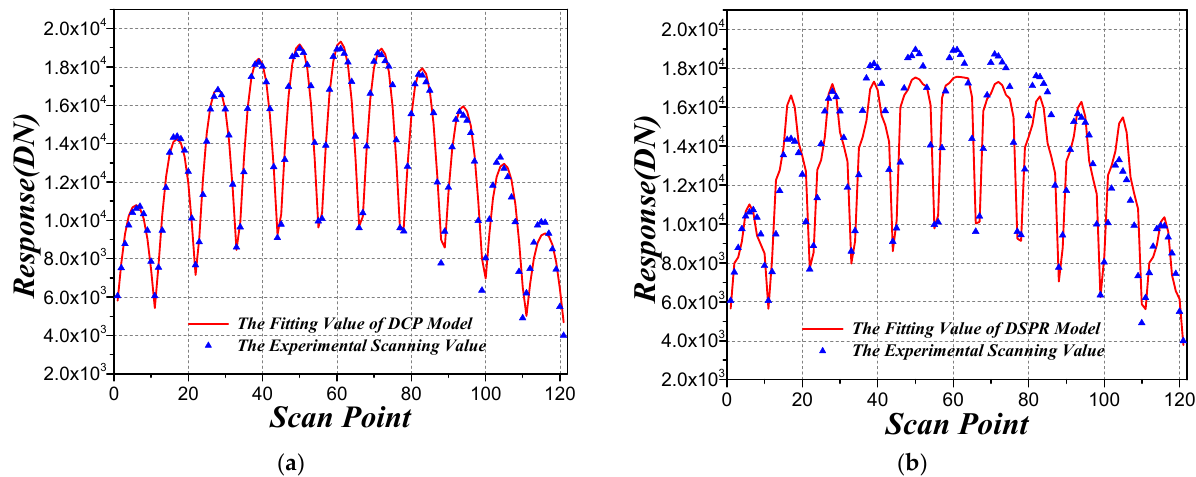
Figure 8. Beam spot scanning response map of the experiment and the fitting value of model ( a ) based on the DCP model; ( b ) based on the DSPR model.